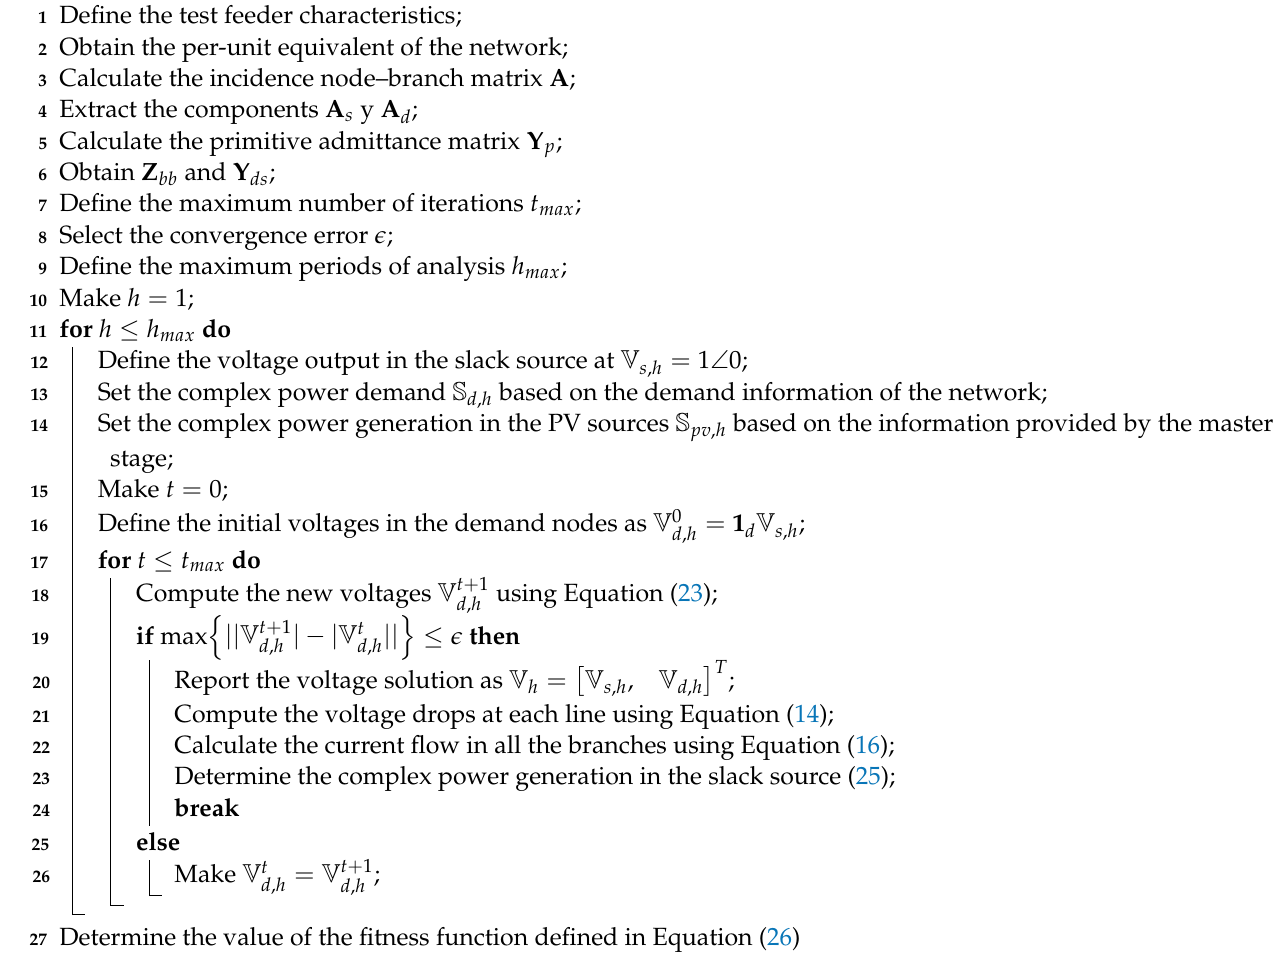
Algorithm 1: Solution of the multiperiod power flow problem using the matricial backward/forward power flow formulation to determine the fitness function of the studied optimization